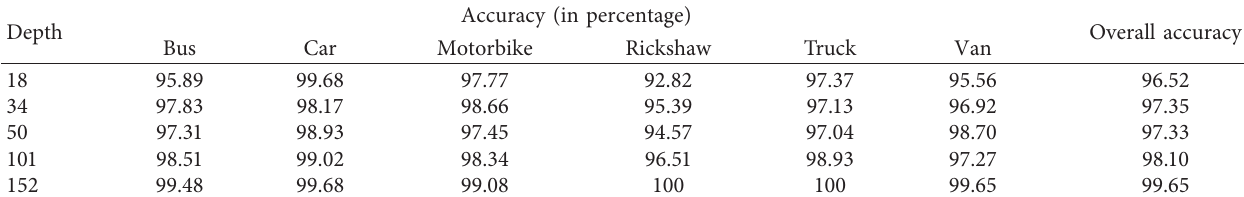
Table 3: Class-wise accuracy of the fine-tuned network with different depth layers on our self-constructed dataset.